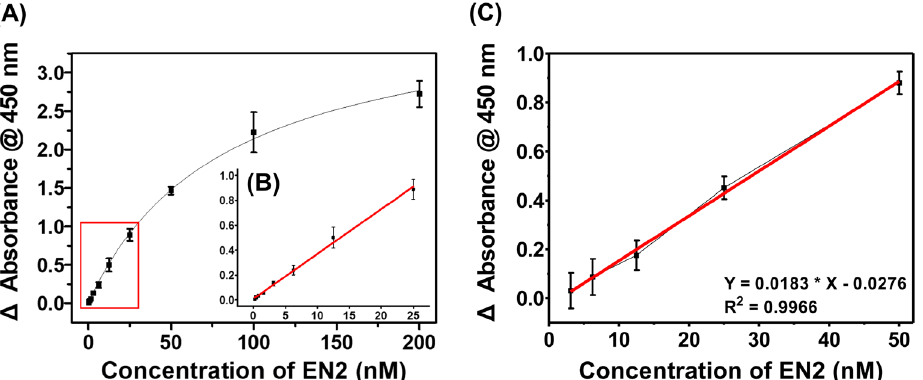
Figure 4. HCR-based aptamer-antibody hybrid ELONA assay for EN2 detection. ( A ), ( B ) ELONA analysis under binding buffer conditions. The calibration curve was obtained in a dynamic range from 0.39 nM to 25 nM, and the LOD was 0.34 nM. ( C ) ELONA analysis for EN2-spiked AUM samples. AUM was diluted in two-fold prior to spiking; the dynamic range was 3.12 nM to 50 nM, with an LOD of 2.69 nM. Bars: ± s.d., n =